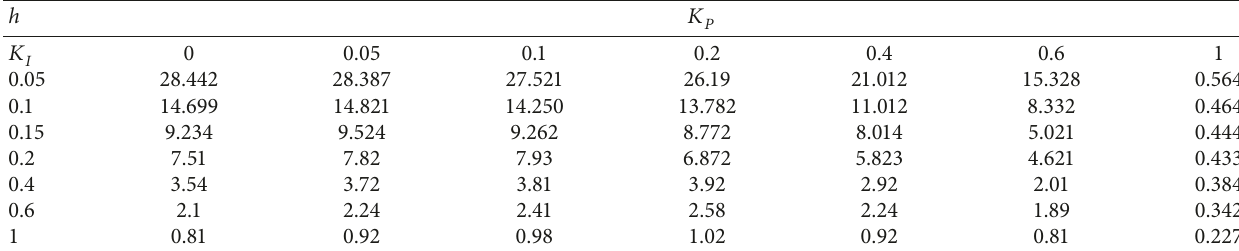
, K ) for two-area LFC with μ � 0 , ϱ � 0 , τ � P I